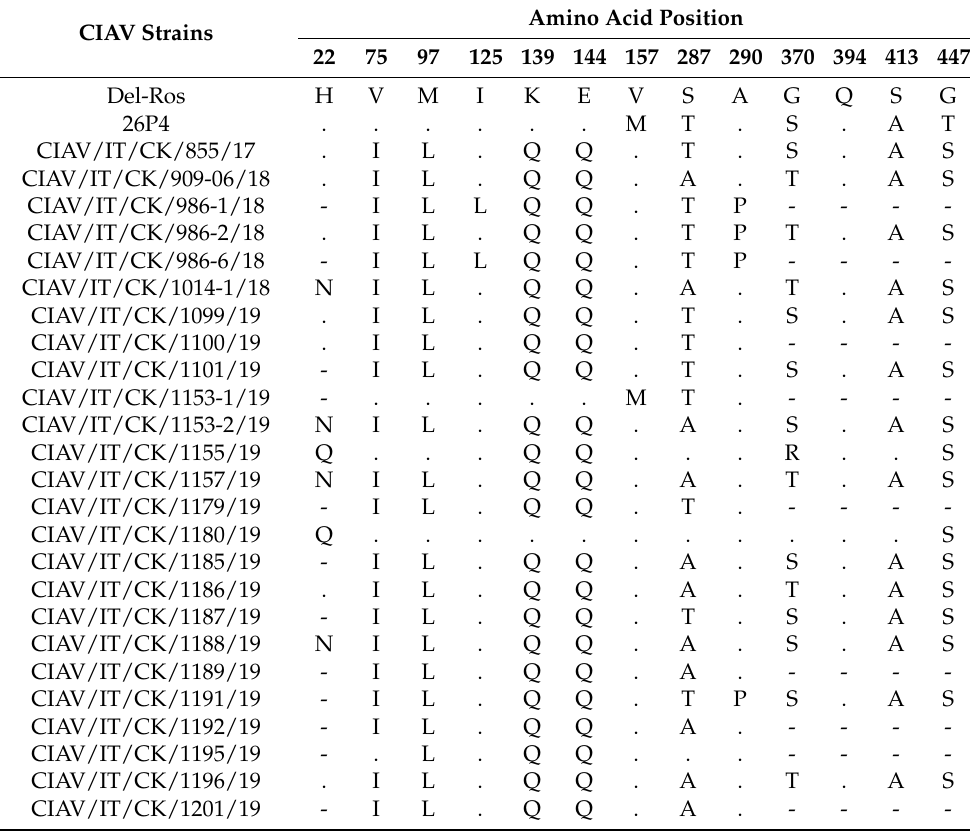
Table 4. VP1 amino acid sequence comparison among the twenty-five Italian CIAV strains detected in the study and vaccine